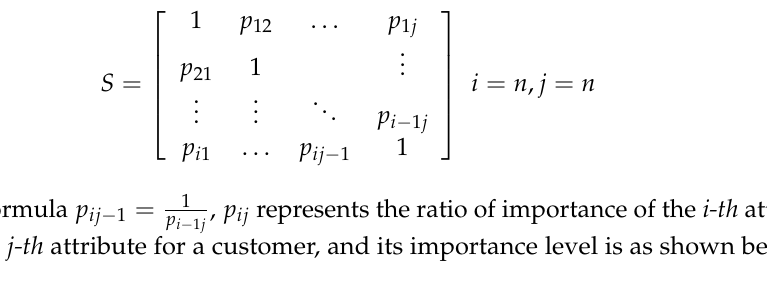
Table 1. Level of importance. Serial Classification of Importance p 1 i and j are equally important 1 2 i is a little more important than j 2 3 i is more important than j 4 4 i is more important than j 6 5 i is absolutely more important than j